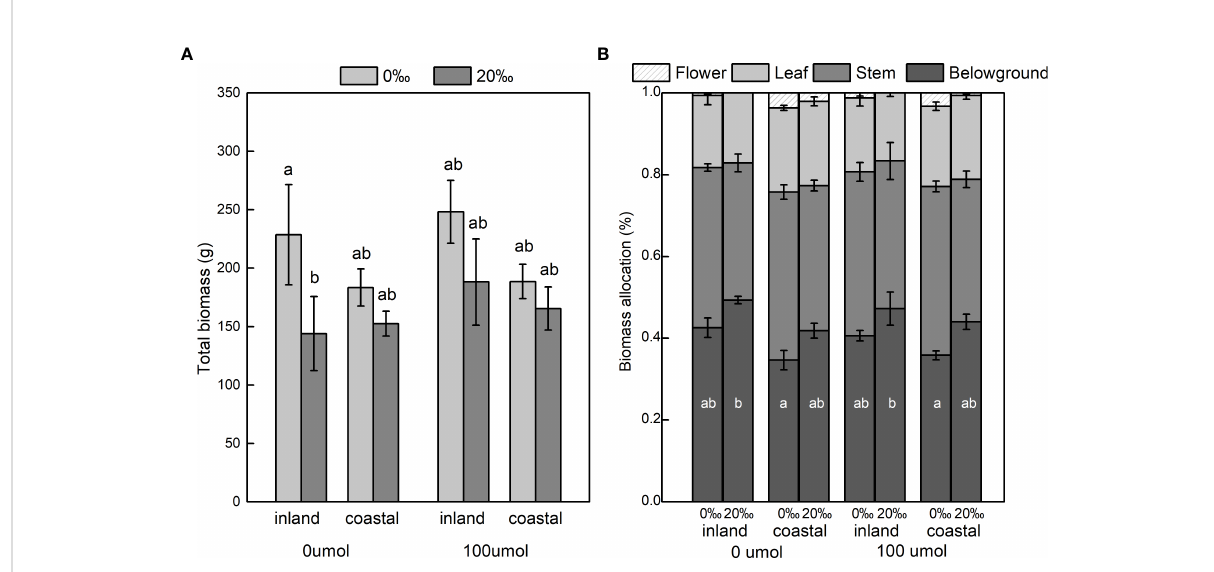
FIGURE 2 Total dry mass (A) and biomass allocation (B) of Phragmites australis populations grown with salinity (0 ‰ vs. 20 ‰ ) and DNA demethylation (0 vs. 100 m mol) treatment, respectively. Mean ± SE. Letters in a indicate signi fi cant differences between all treatments for total biomass, and letters inside bars in b indicate differences between treatments for each plant part. Bars sharing the different letters are different at P < 0.05.